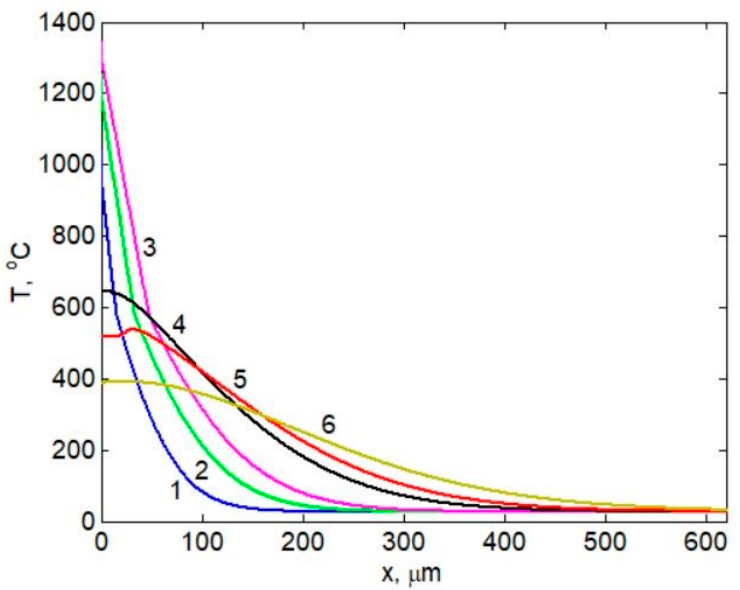
Figure 8. Temperature distribution in depth for the 1- µ m coated silumin at different points of time during electron beam irradiation: 50 (curve 1), 100 (curve 2), 150 (curve 3), 300 (curve 4), 400 (curve 5), and 600 µ s (curve 6).